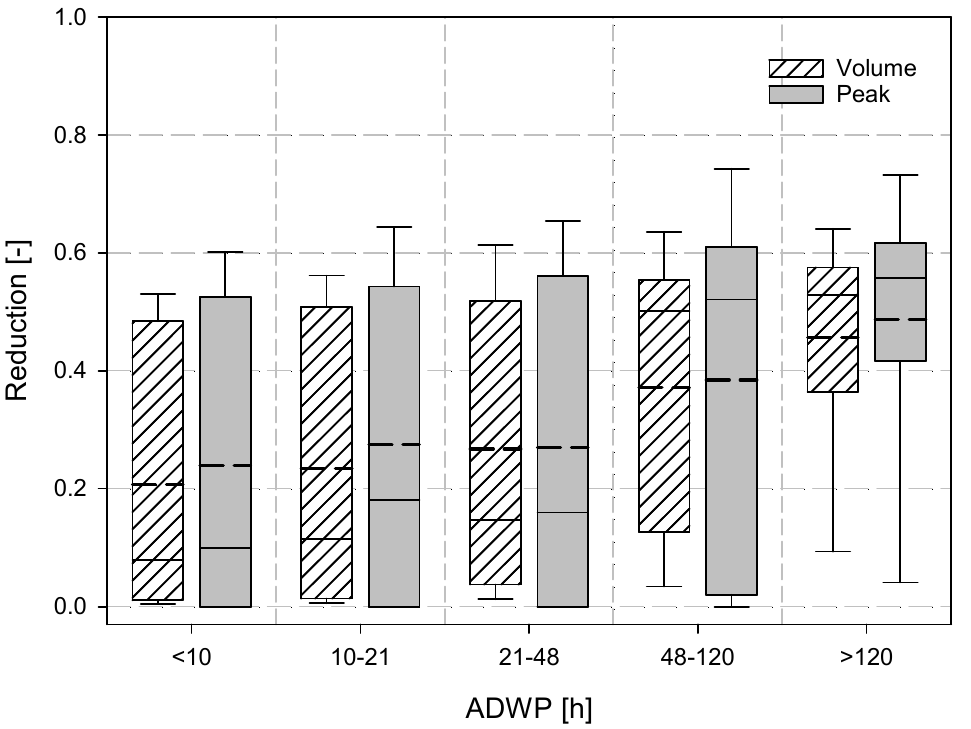
Figure 6. Non-parametric distribution of the volume (hatched box) and peak (grey box) reduction rates simulated at the catchment scale for each class of the ADWP. The solid and dashed lines within the box mark indicate the median and mean values respectively.